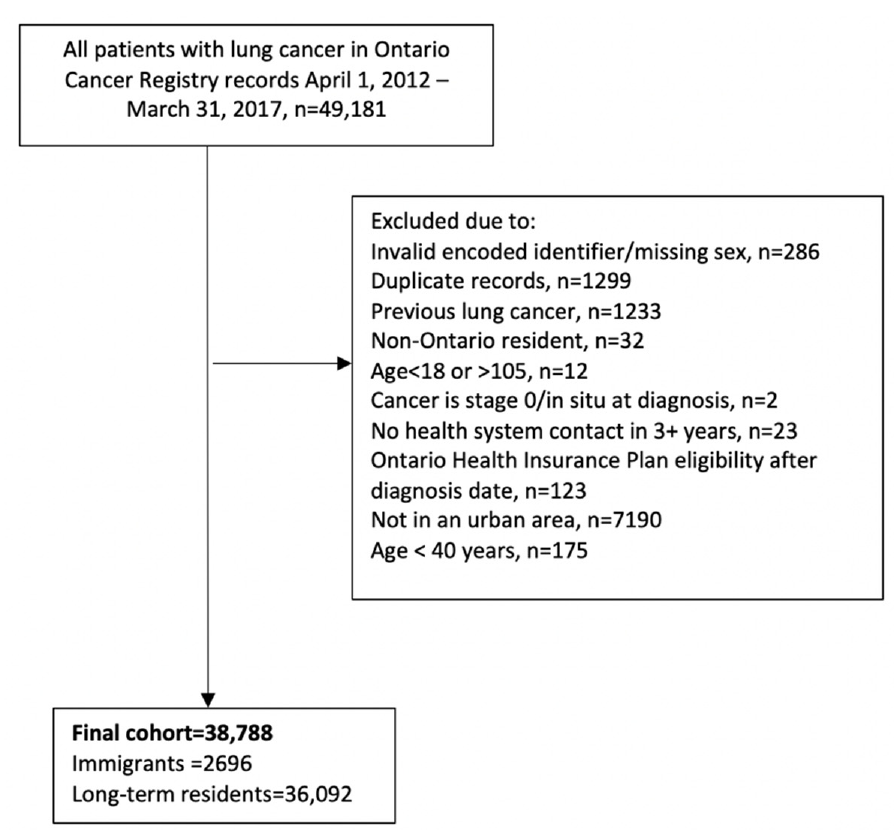
Figure 1. Creation of study cohort of 38,788 patients diagnosed with lung cancer in Ontario, 1